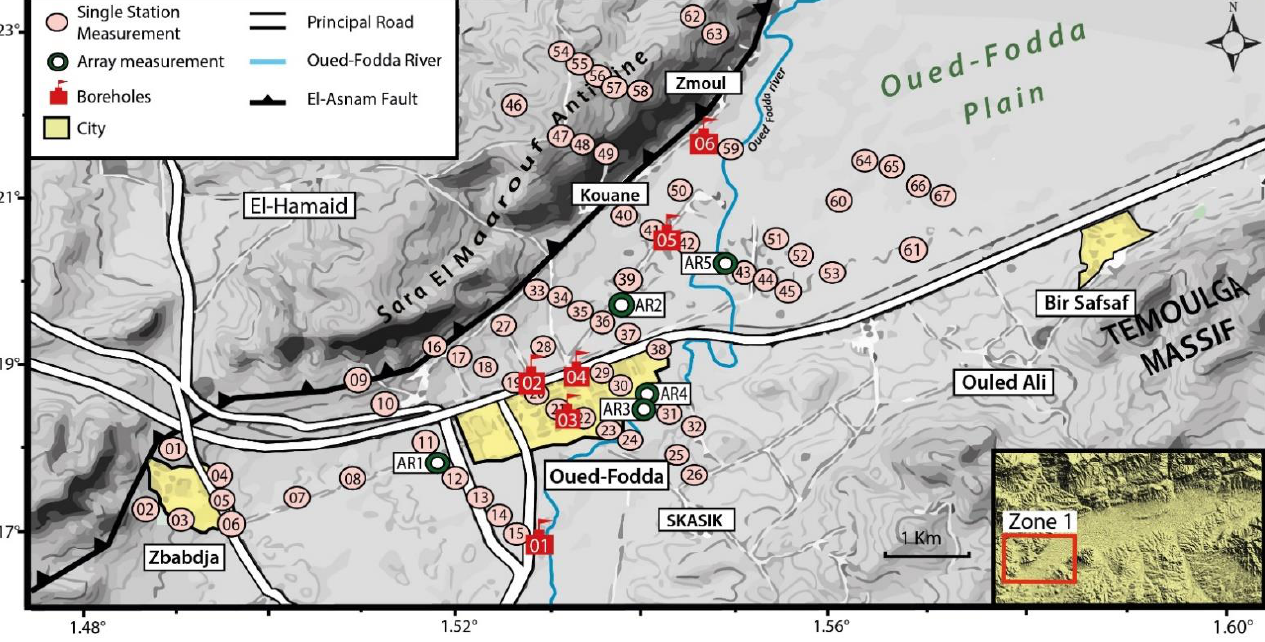
Figure 5. Compiled data in Zone 2.